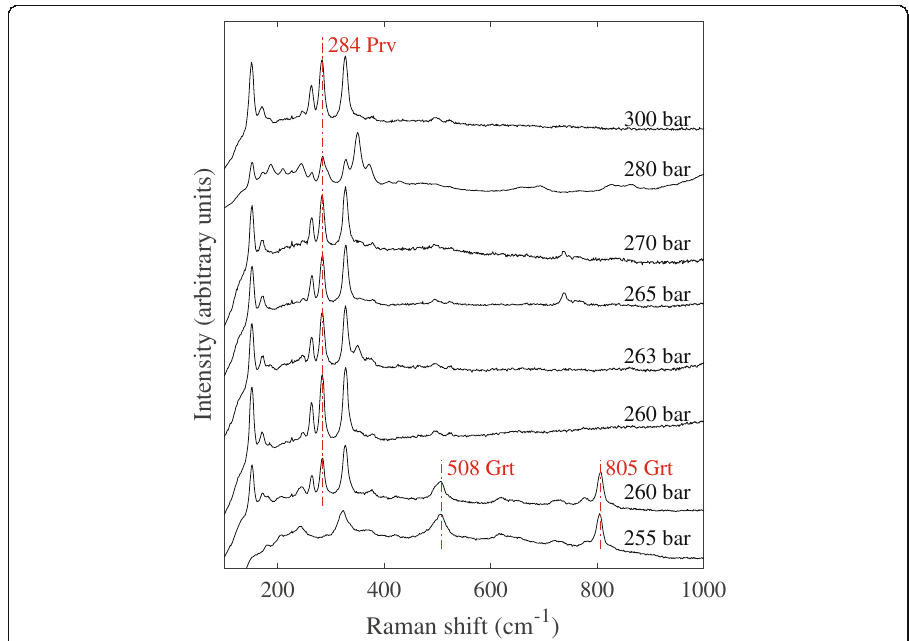
Fig. 6 The Raman spectra from recovered CaGeO 3 samples obtained from the experiments listed in Table 1. Characteristic peaks of garnet-structured and perovskite-structured polymorphs are labelled by the abbreviations ‘ Grt ’ and ‘ Prv ’ , respectively